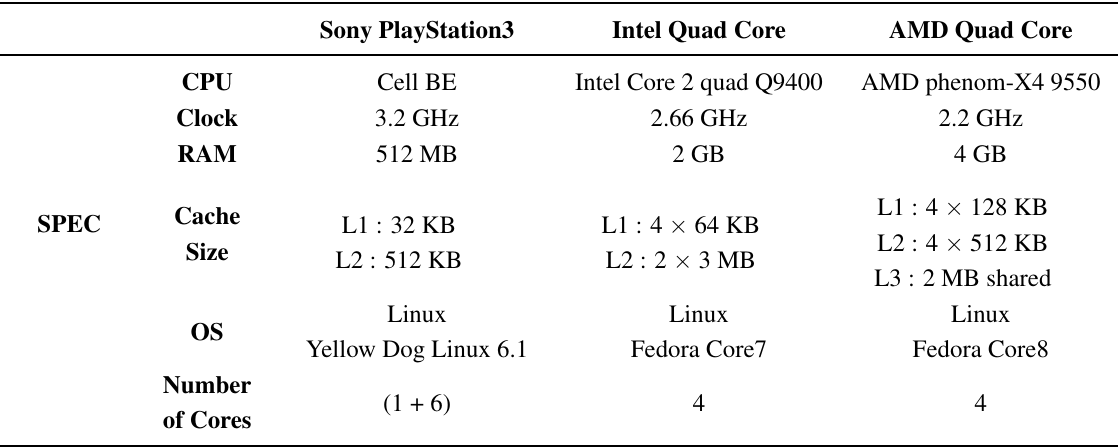
Table 2. Experimental